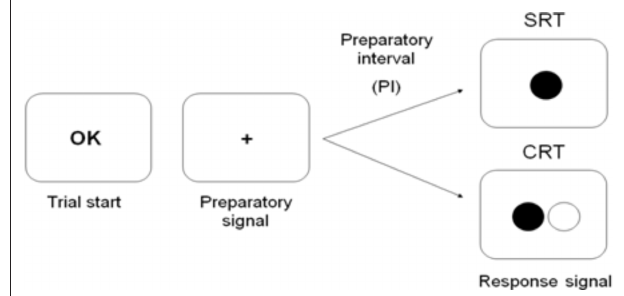
FiGure 1 | Figural description of the response preparation